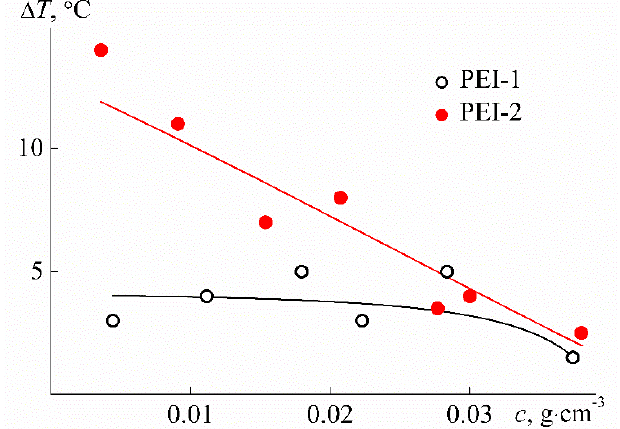
Figure 15. Concentration dependencies of T for aqueous solutions of PEI-n.